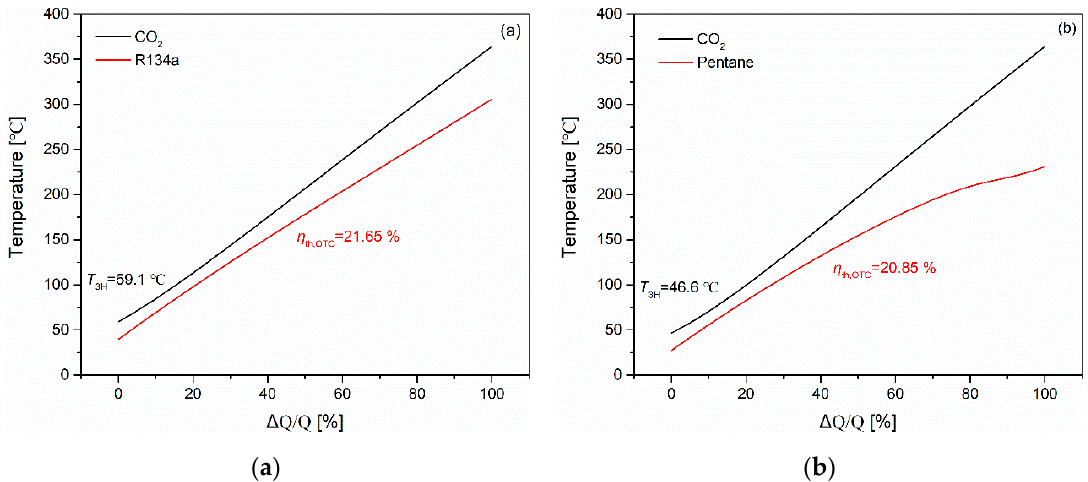
Figure 14. T-Q diagram of CO 2 and organic fluid ( a ) R134a, ( b ) Pentane in the intermediate heat exchanger (IHE) of CO 2 -TC / OTC.